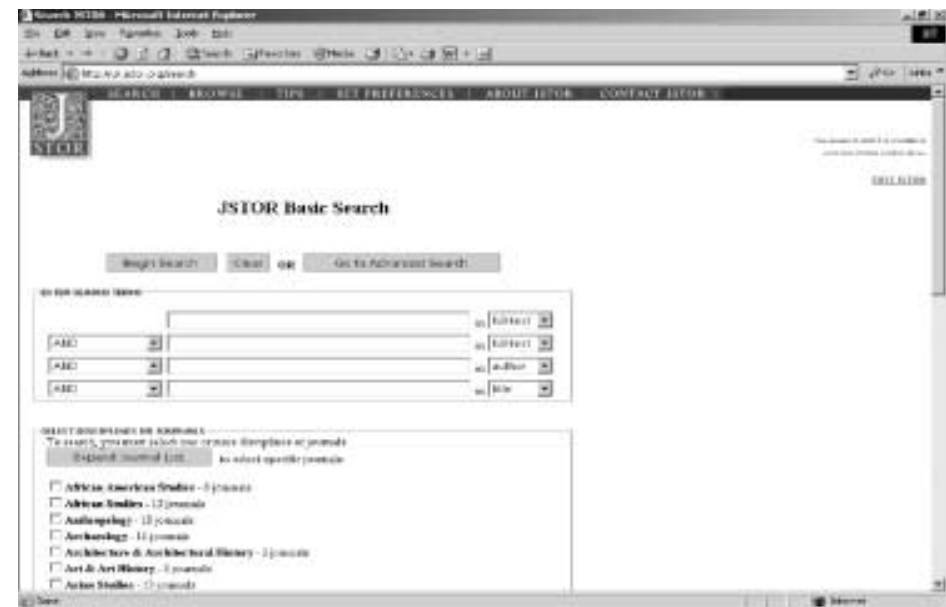
Figure 3. The JSTOR basic search interface—more challenging for novices than